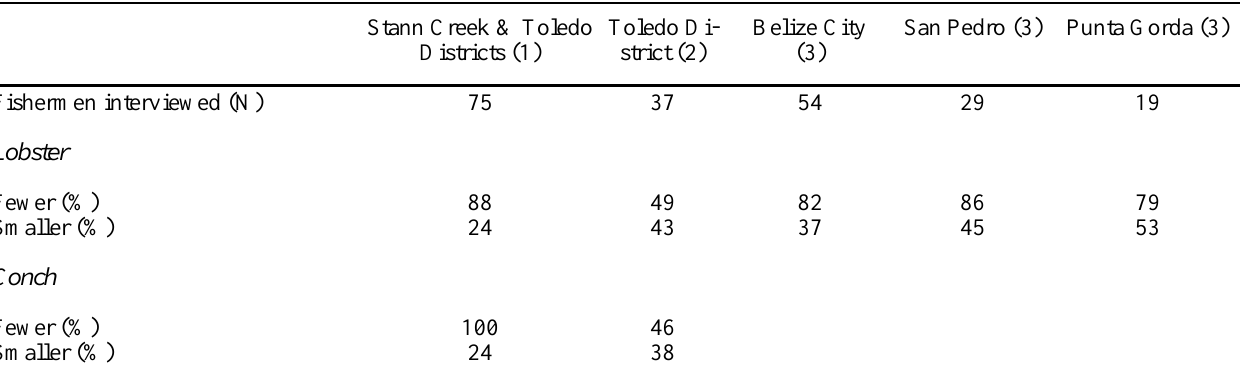
Table 2. Summary of results from interviews with fishers about changes in lobster and conch